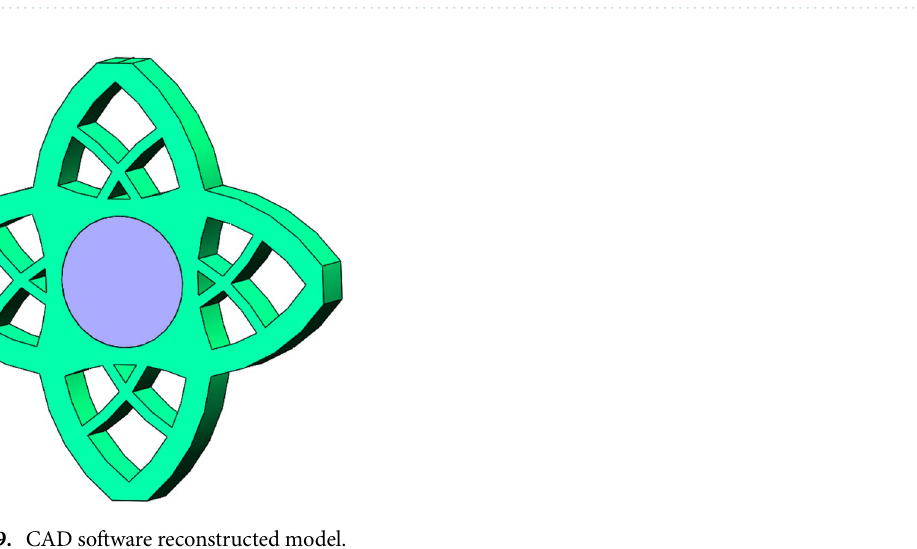
Figure 18. Comparison of optimization results with different optimization algorithms. ( a ) HCAM optimization result ( b ) FEM optimization result.